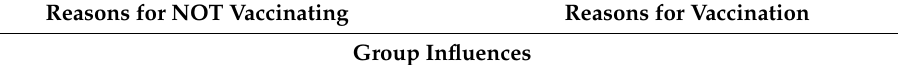
Table 12. Description of theme Group influences with